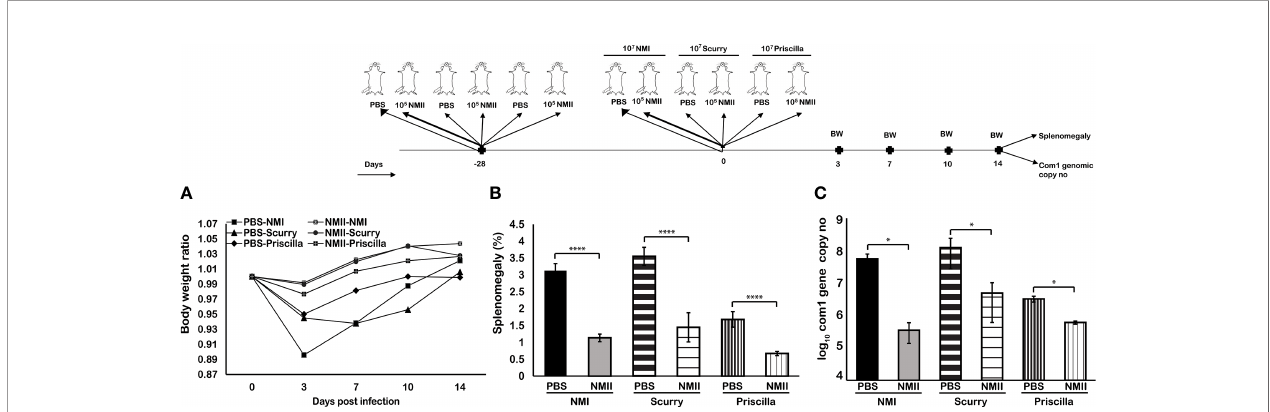
FIGURE 8 | Mice immunized with viable NMII bacteria confer protection against other virulent strains of C. burnetii. BALB/c mice were IP vaccinated with 1 × 10 5 GE of viable NMII and IP challenged with 1 × 10 7 GE of NMI, Scurry, or Priscilla at 28 days dpv. Body weight ratio (A) , splenomegaly [ (B) , % of spleen weight/body weight], and bacterial burden (log 10 C. burnetii com1 gene copy numbers) in the spleen (C) were evaluated at 14 dpi. Each experimental group includes four mice, with error bars representing the standard deviations from the means. *p < 0.05; ****p < 0.0001, as determined by Welch t test using